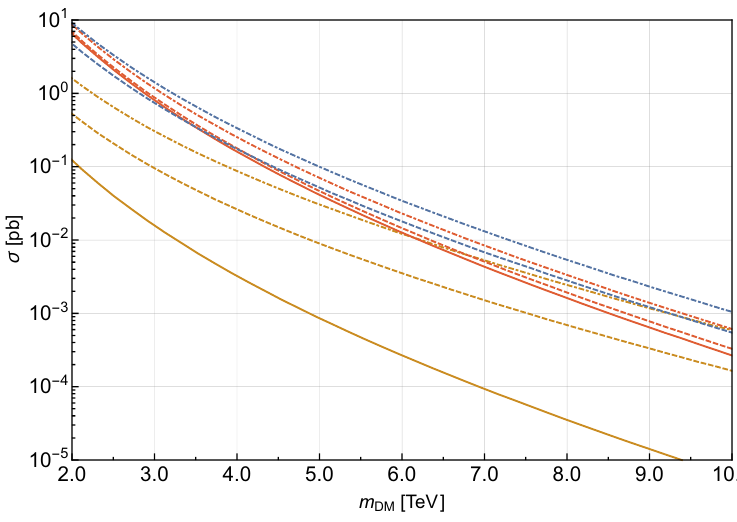
Figure 10 . Production cross-sections for X C3 X C3 (orange), X M8 X M8 (red), and X C3 X M8 (blue). For each process, we take the new physics coupling to be (cid:11) NP = 0 (solid), 7 : 0 (cid:11) s (dashed), and 12 : 9 (cid:11) s